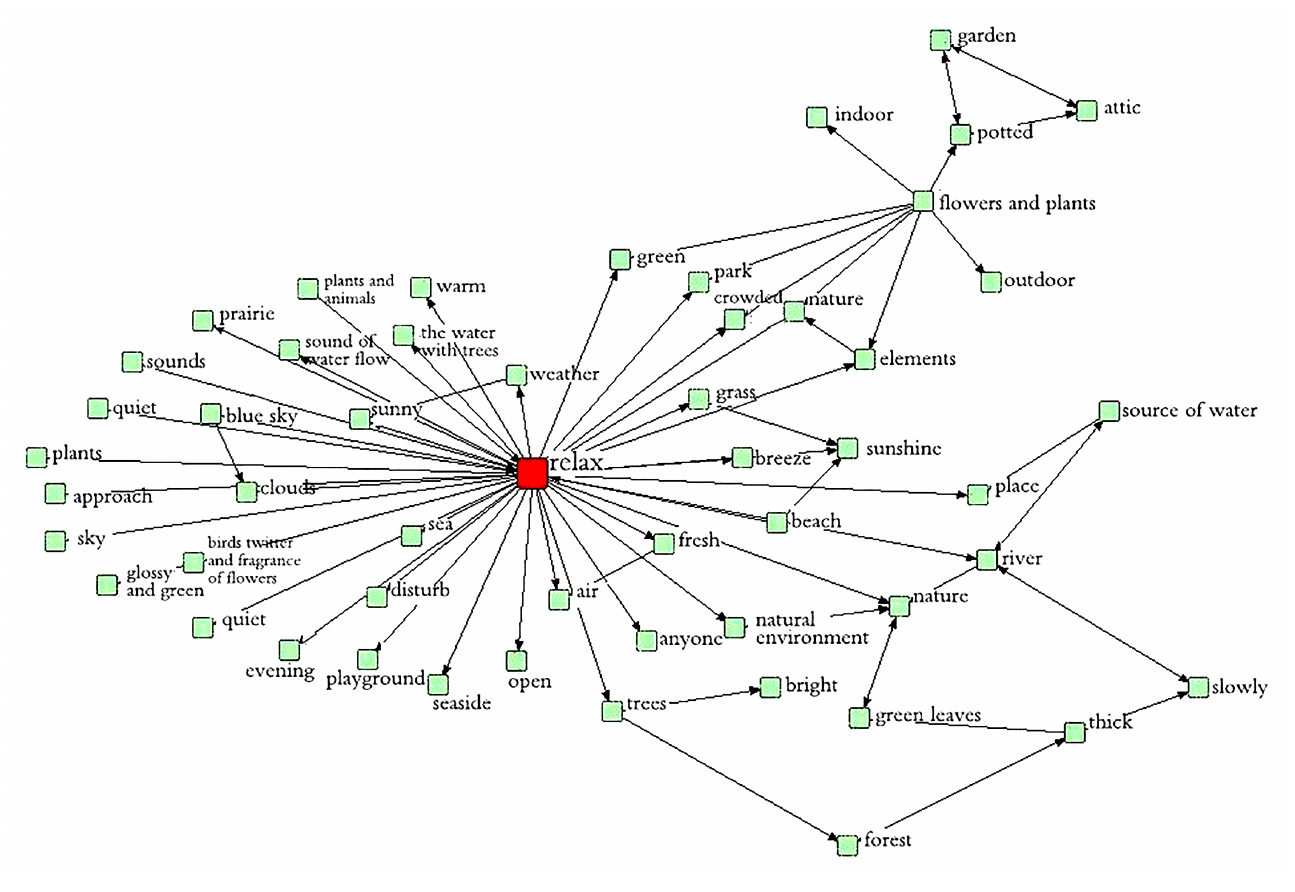
Figure A7. Semantic network analysis diagram of a relaxed environment.